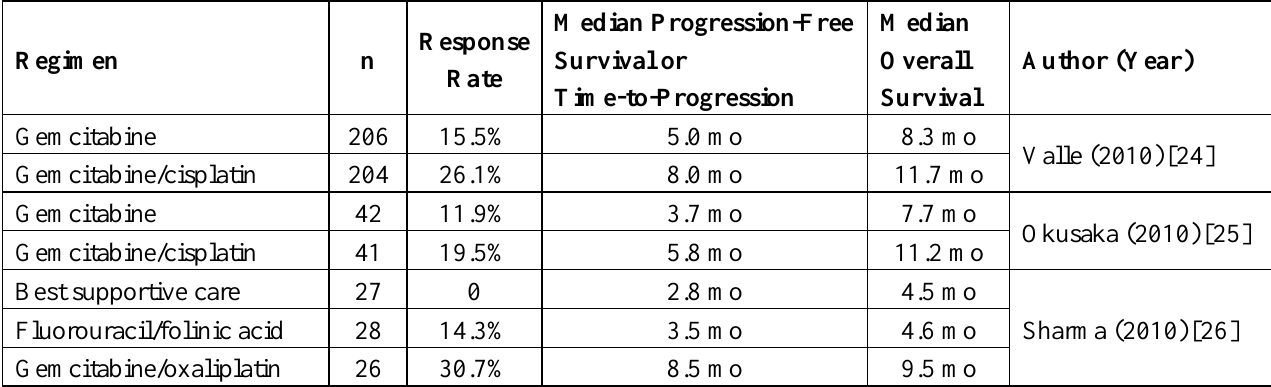
Table 2. Randomized clinical trials of gemcitabine-based regimens for unresectable biliary tract